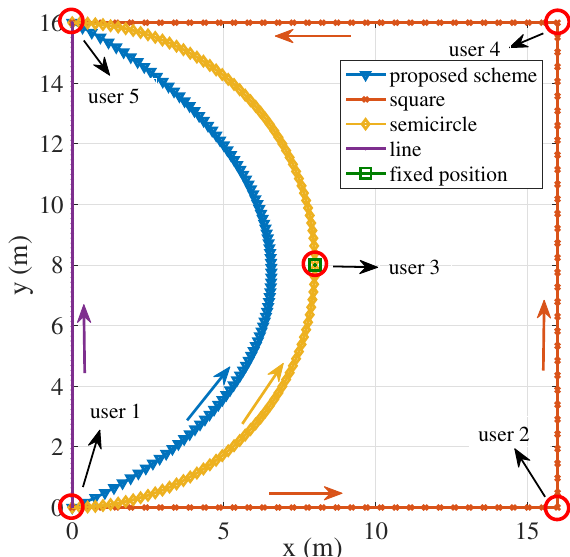
Figure 4. Different trajectory of the Unmanned Aerial Vehicle (UAV) under the time constraint T = 5 s ( I 1 = 4 × 10 7 bits, I 2 = 5 × 10 7 bits, I 3 = 6 × 10 7 bits, I 4 = 7 × 10 7 bits and I 5 = 8 × 10 7